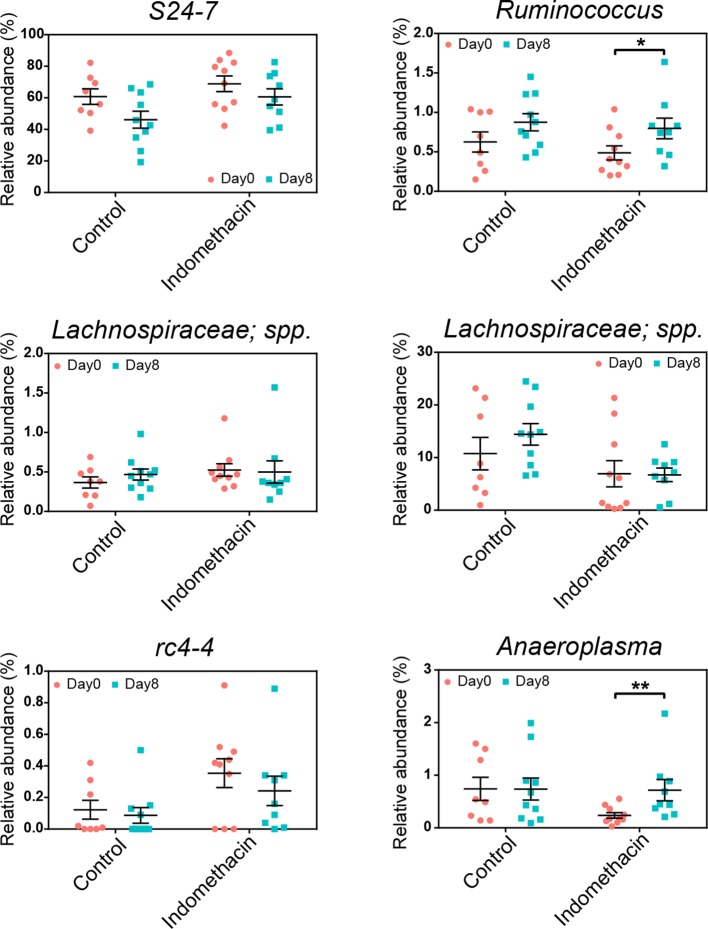
Longitudinal effects of chronic indomethacin treatment on genera abundance in fecal microbiota.Fecal microbiota composition before (day 0) and after (day 8) treatment in mice receiving control or indomethacin diet is analyzed by 16S rRNA gene profiling. Indomethacin induced increases in the relative abundance of Ruminococcus and Anaeroplasma at day 8. *p<0.05, **p<0.01 by two-tailed Mann-Whitney test. N=9–10/group. Mean ± S.E.M. shown.